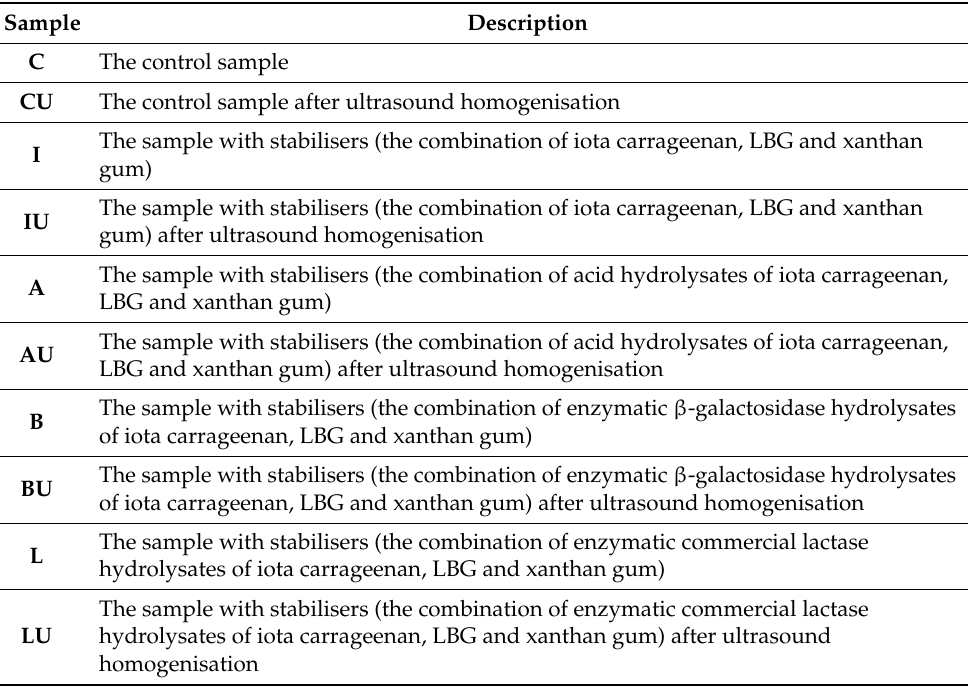
Table 1. The description of abbreviations of